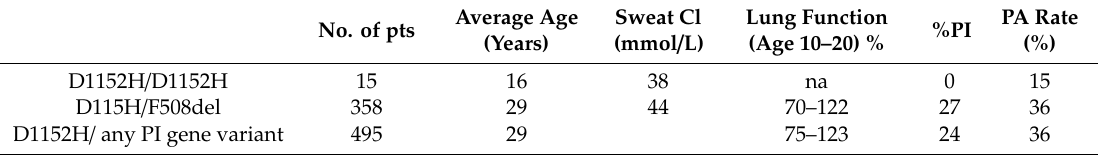
Table 1. Clinical information on a total of 556 patients from the CFTR2